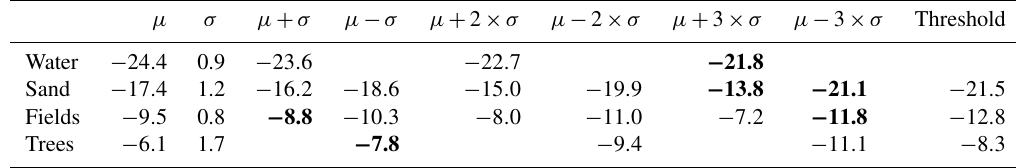
Table 1. Determination of thresholds for a sampling duration of 1 month and a 3 × 3 boxcar filter. Values in bold are those that have been used to calculate the threshold indicated in the last column. All values are in decibels (dB). µ – mean. σ – standard deviation. µ